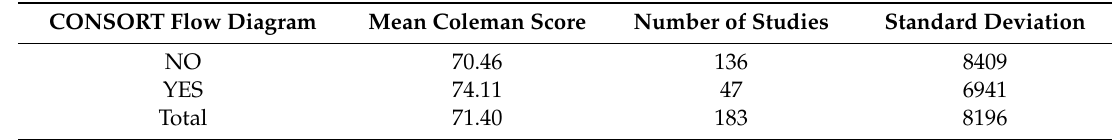
Table 3. Di ff erence in mean Coleman score between articles with and without a CONSORT diagram. CONSORT Flow